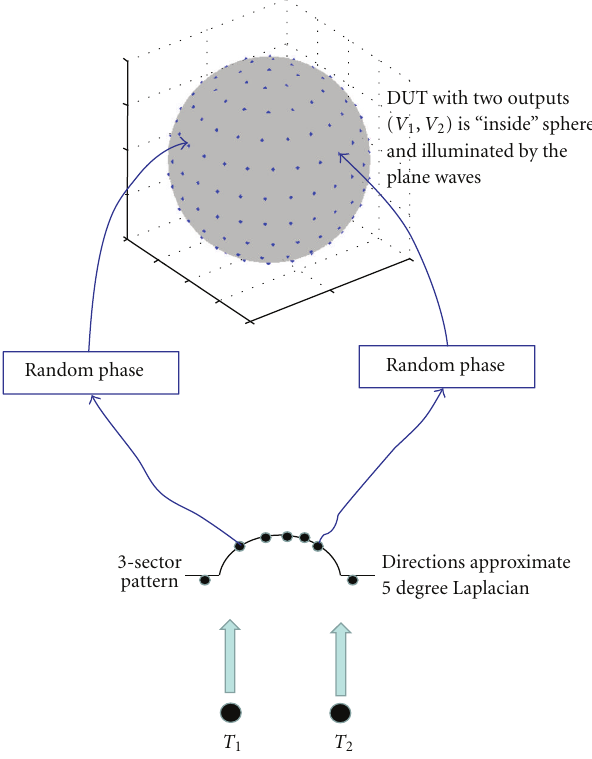
Figure 16: Channel model employing an isotropic environment. Each point on the base station pattern is randomly paired with a plane-wave propagation direction illuminating the DUT. In addition, each “pairing” is supplied by a random phase. The multiple states of the model are obtained by changing the pairing and the random phases.